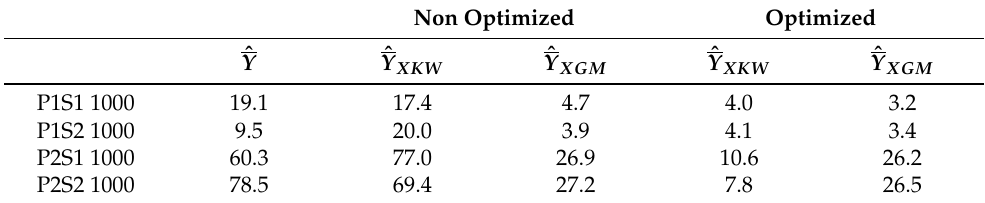
Table 4. Relative RMSE (%) for each optimized